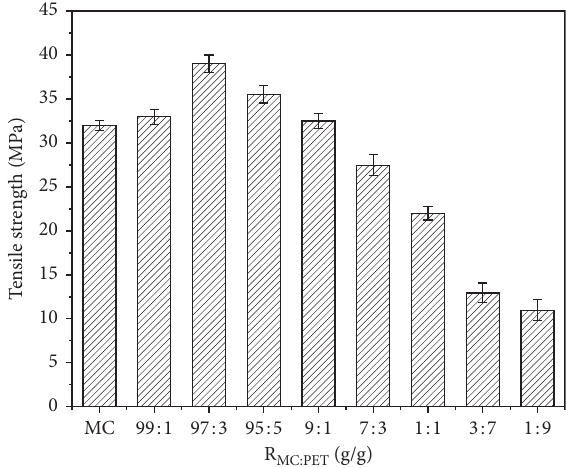
Figure 5: MC/PET mass ratio (R MC:PET ) dependent on tensile strength of the neat MC film and MC/PET